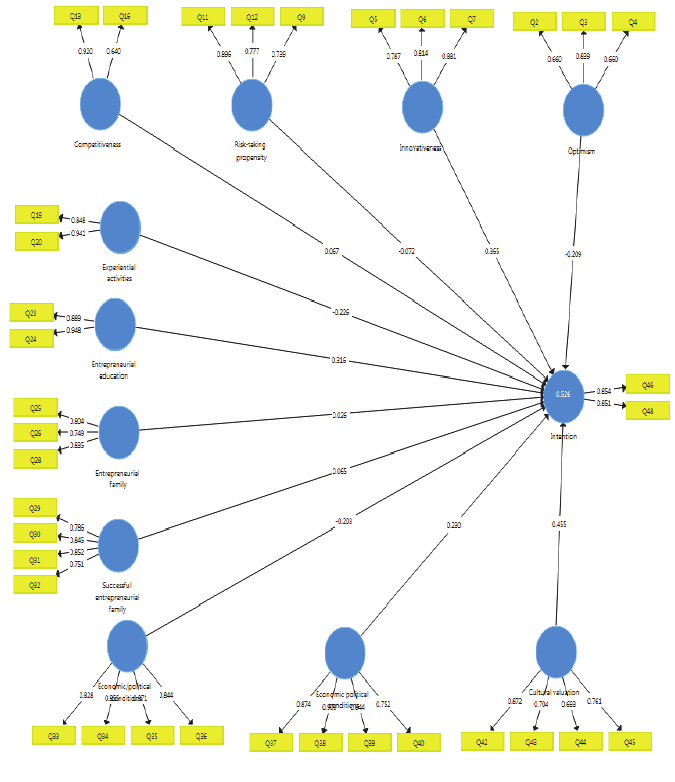
Fig. 1. The study model